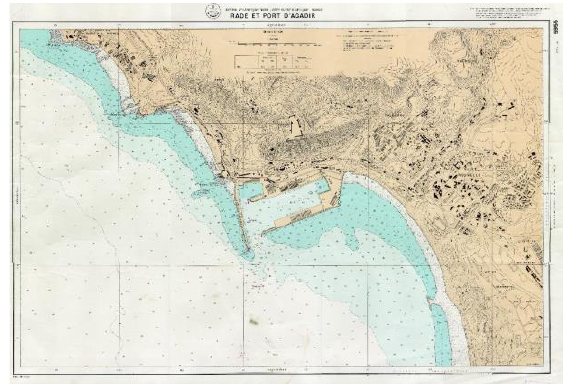
Figure3 . Marine navigation chart (SHOM).